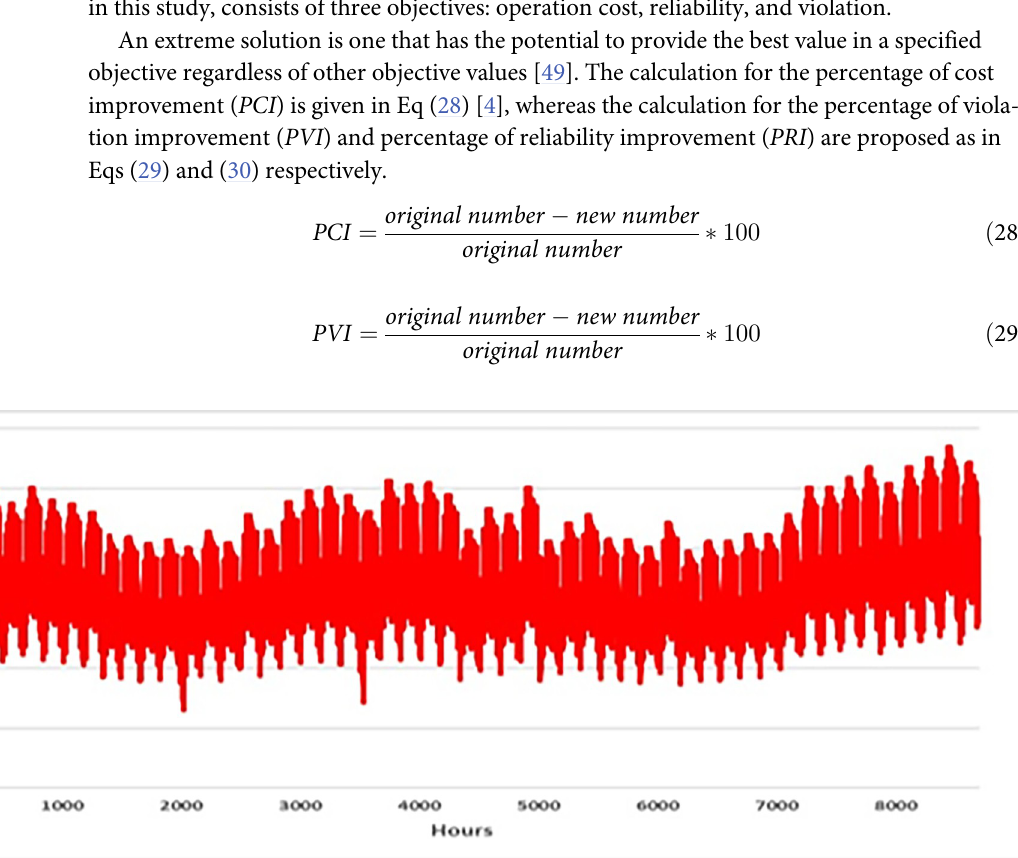
Fig 2. Expected hourly load demand